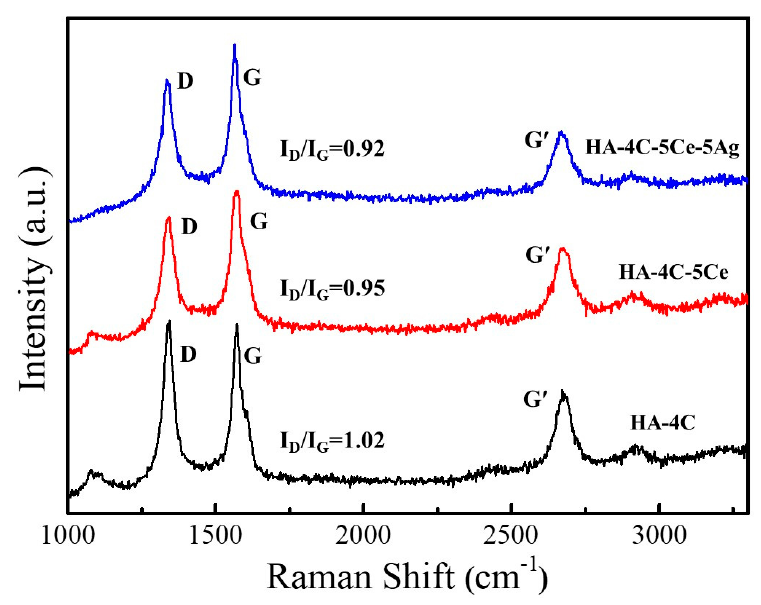
Figure 8. Raman spectra after wear of HA-4C, HA-4C-5Ce, and HA-4C-5Ce-5Ag plasma-sprayed coatings.